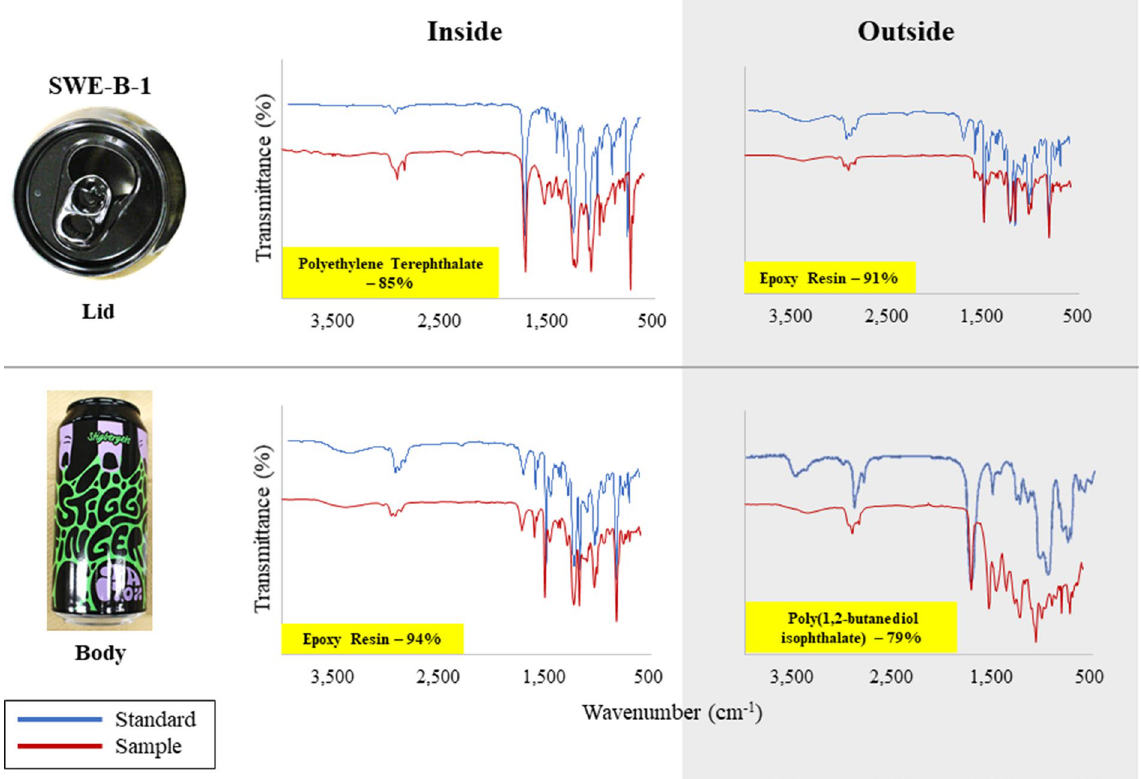
Figure 1. FTIR results for polymer identification in coating film of a beer can.